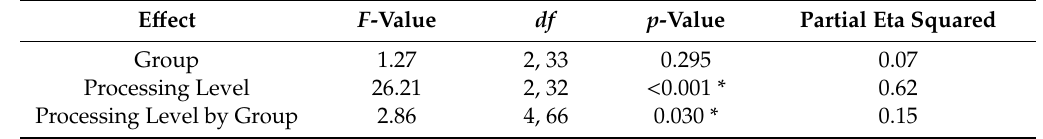
Table 2. Summary of ANOVA for Group, Processing Level, and Session E ff